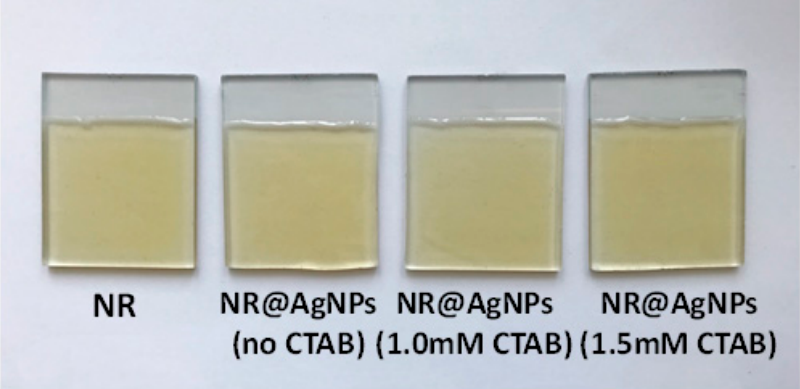
Figure 3. Digital photographs of the NR, NR@AgNP (no CTAB), NR@AgNP (1.0 mM CTAB) and NR@AgNP (1.5 mM CTAB) films cast onto ITO glass substrates as triboelectric electrodes.